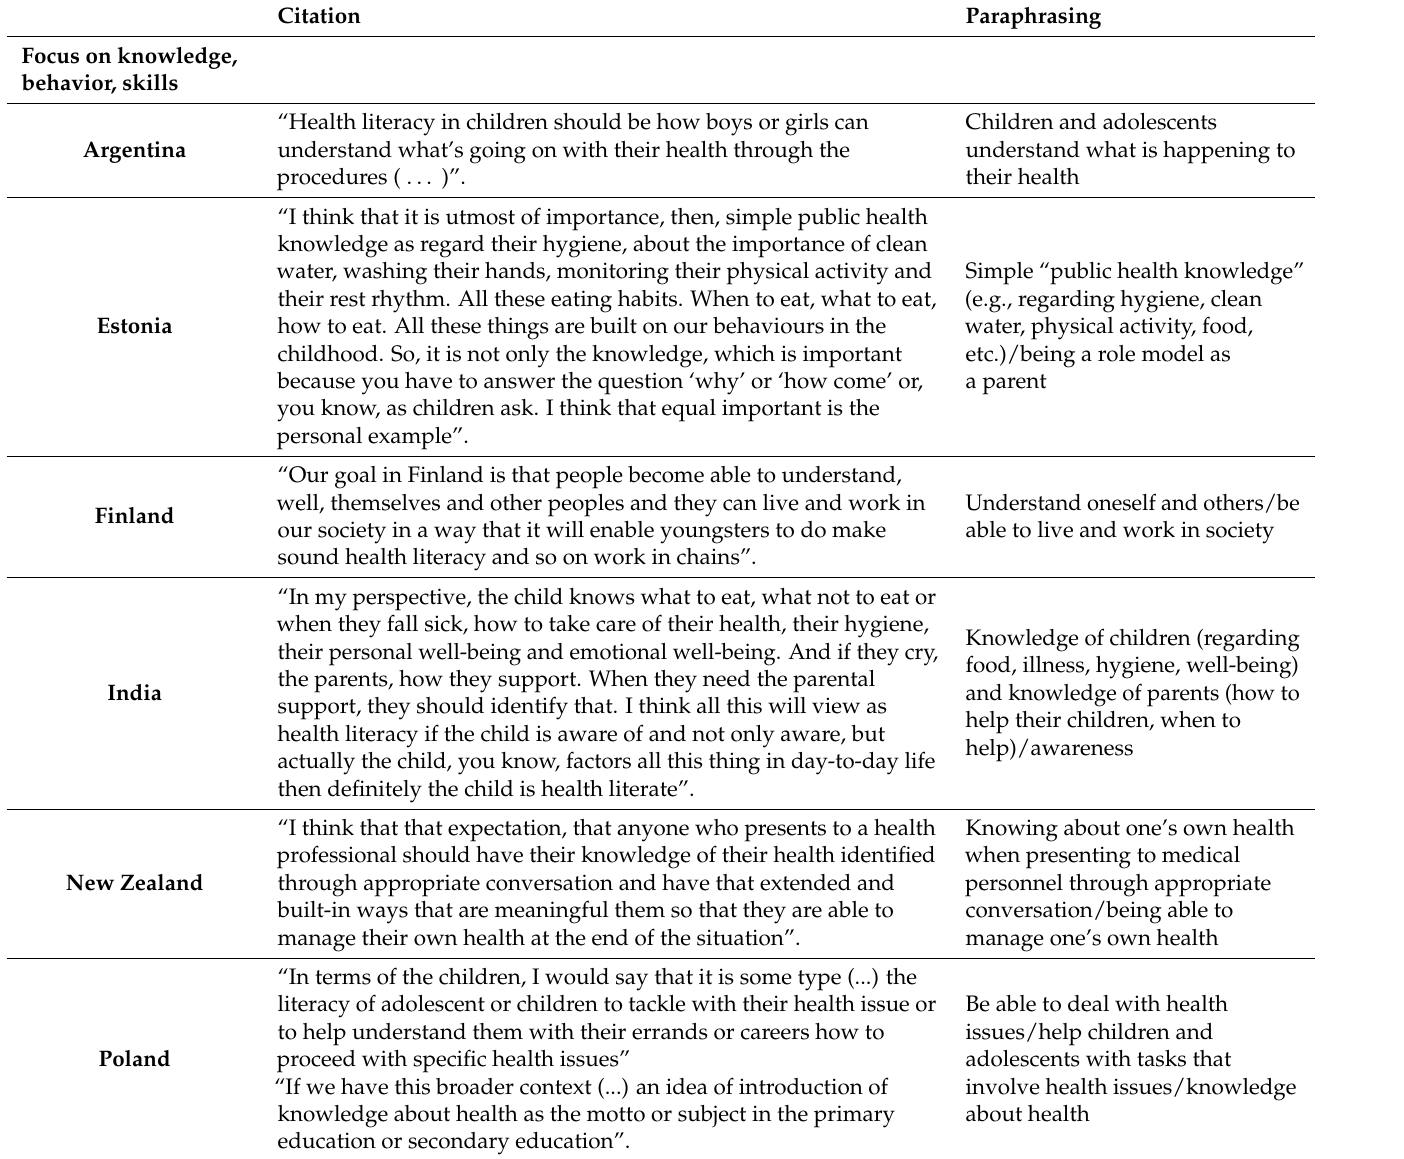
Table A2. Health Literacy at the individual level (focus on knowledge, behavior,